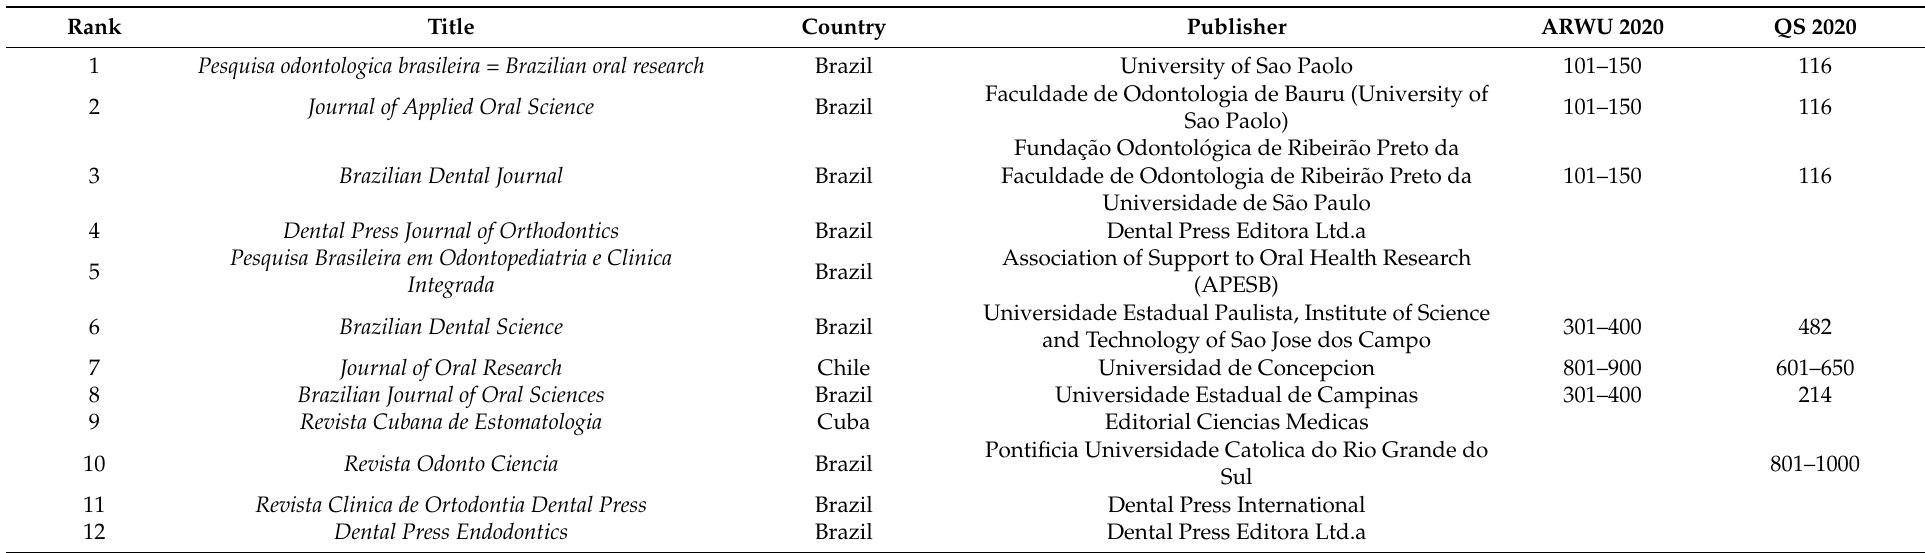
Table 4. Latin American Journals in the Dentistry Area and ARWU 2020 and QS 2020 Ranking